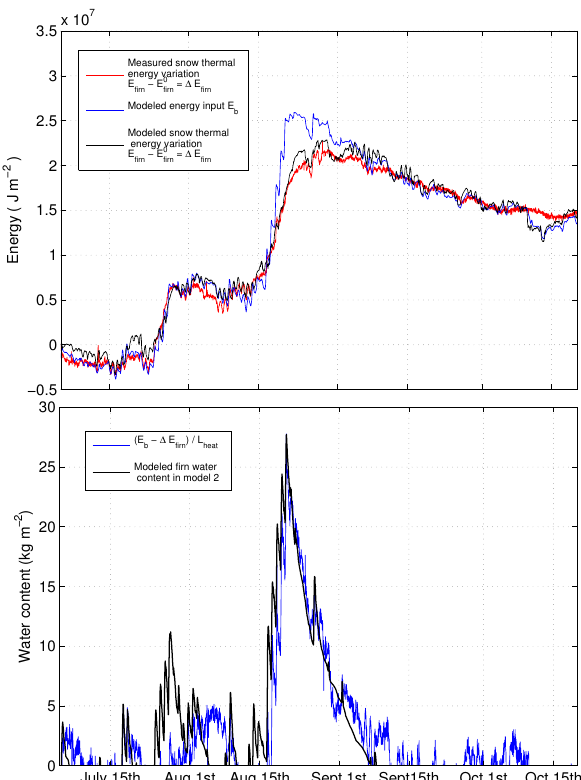
Fig. 4. (a) Modeled cumulative energy input in firn from surface energy balance ( E b , blue line), measured and modeled firn thermal energy E firn (red and black lines, respectively). (b) Energy differ- ence between the energy input calculated from the SEB ( E b ) and firn thermal energy ( E firn ) compared to modeled water content in firn using model 2 (integrated on the vertical